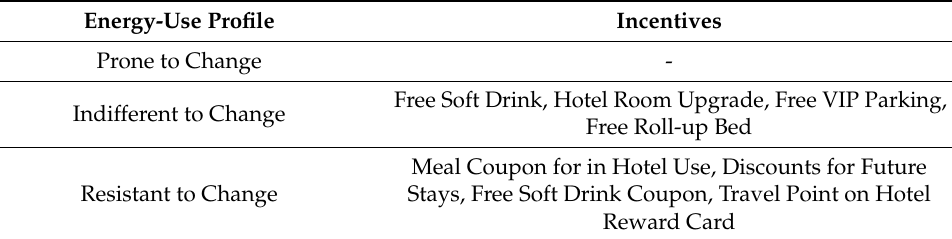
Table 4. Assigning proposed incentives to the hotel guests based on their energy-use